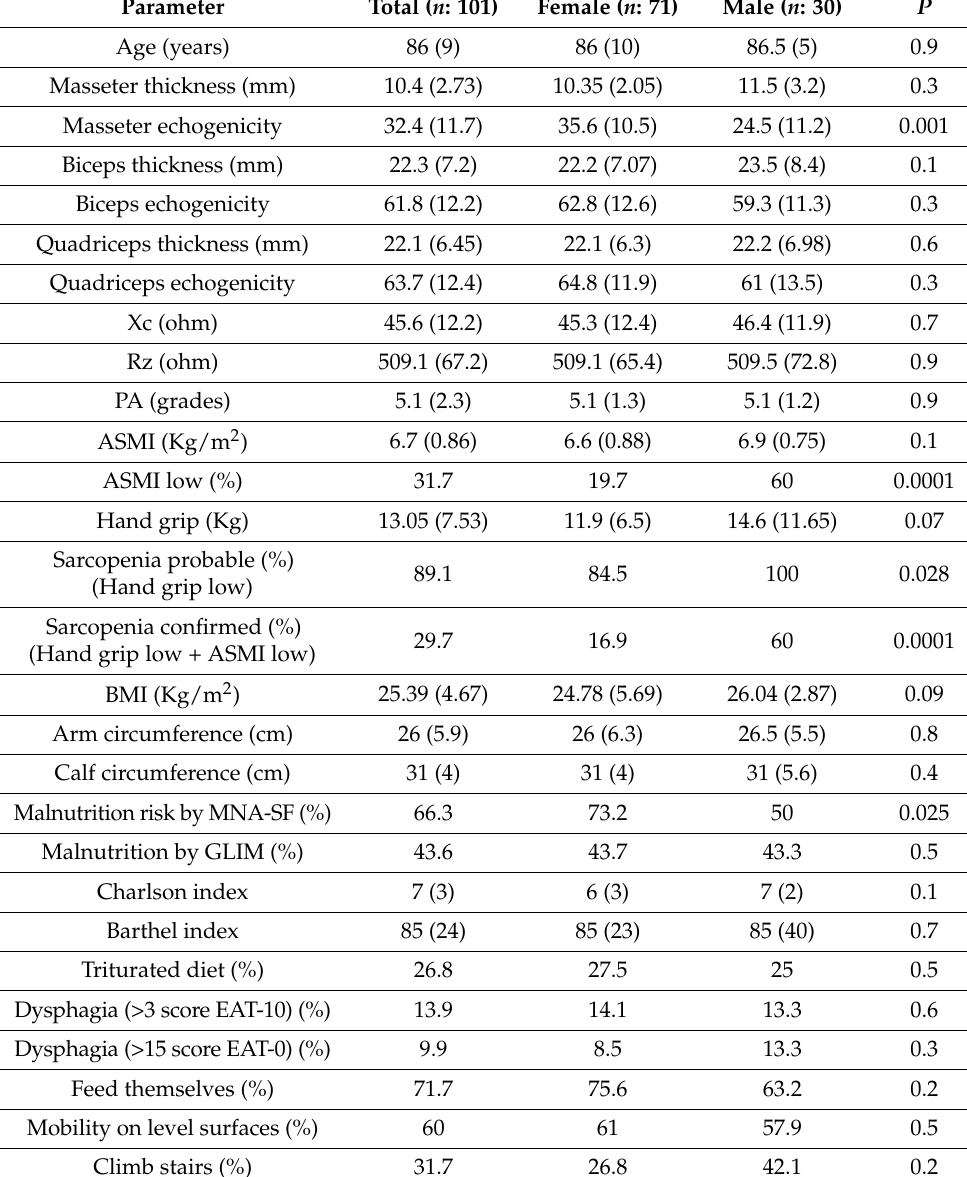
Table 1. Characteristics of the population according to the studied variables and